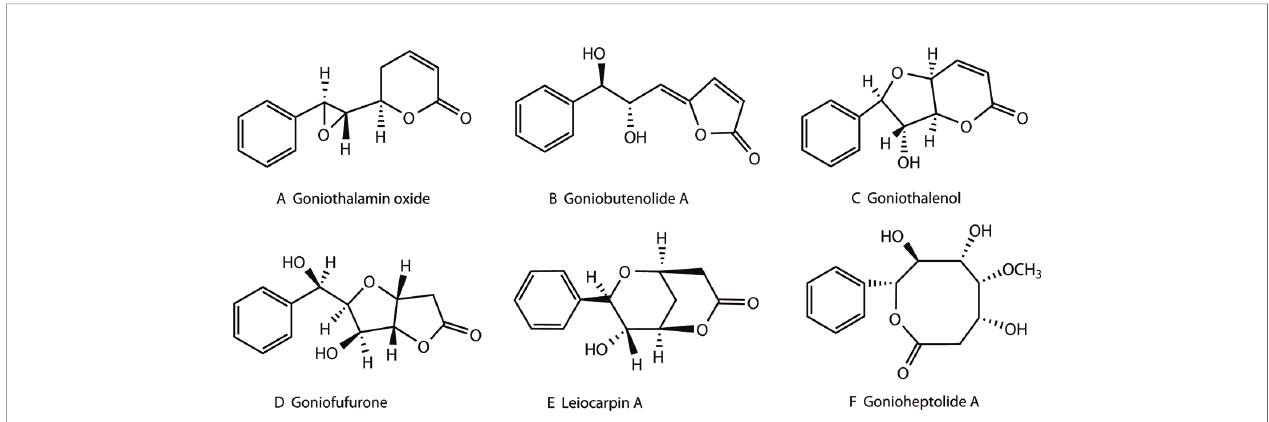
FIGURE 1 | Structures of different styryllactones. Styryllactones are classi fi ed based on different structural skeletons as follows: styrene -pyrone (A) , styrene -furanone (B) , furan -pyrone (C) , furan -furanone (D) , pyran -pyrone (E) , and heptyl esters (F)